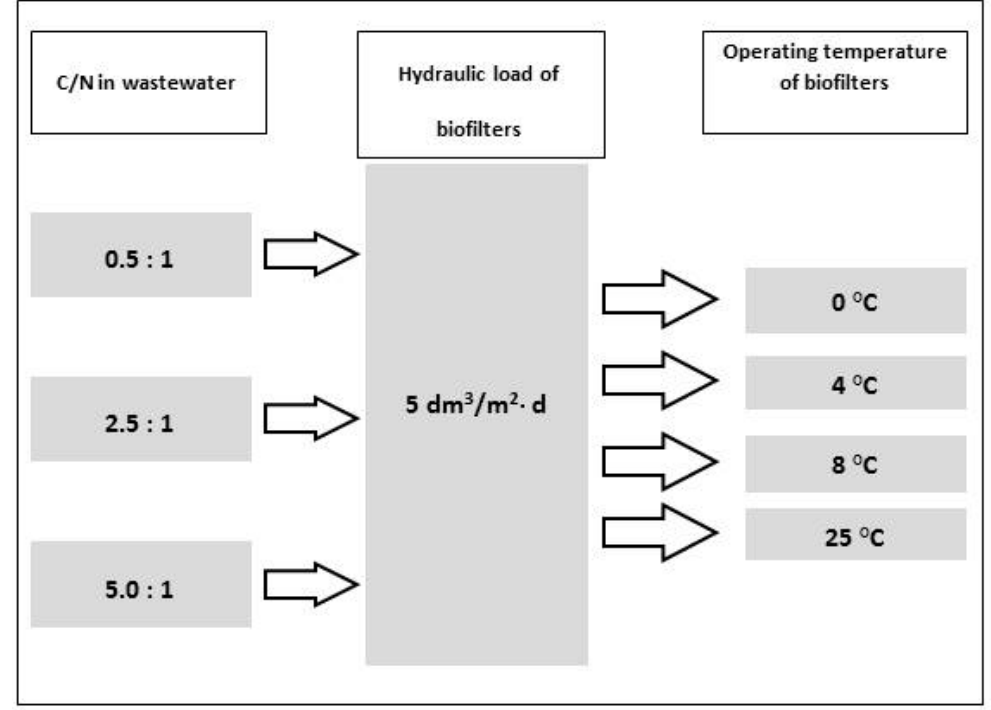
Figure 2. Research scheme.